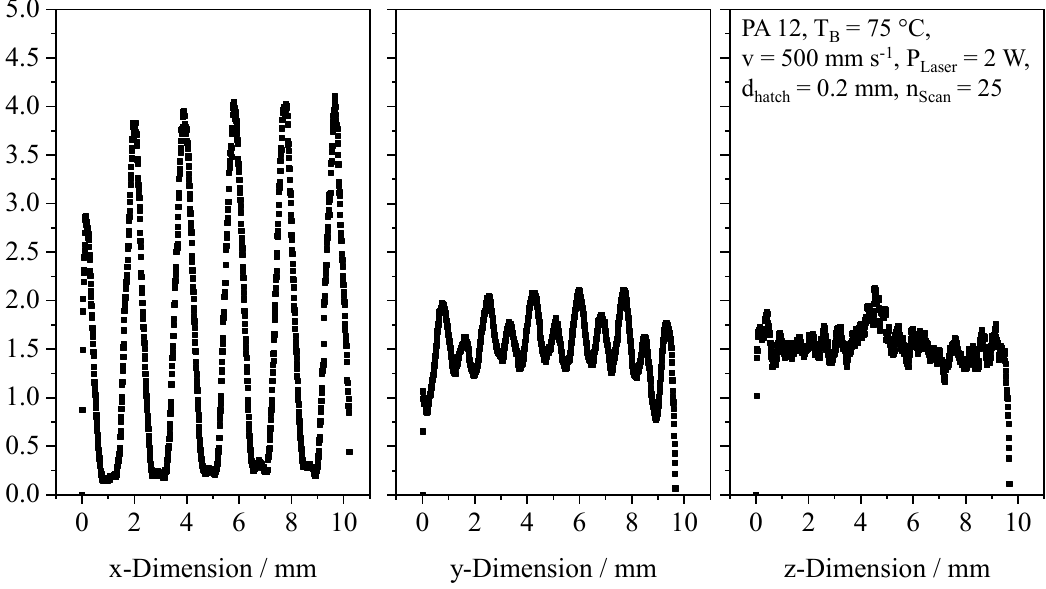
Figure 12. Spatial porosity distribution of a cubic sample, applying fractal sequencing of sub-seg- ments, d Smoothing = 0.2 mm.